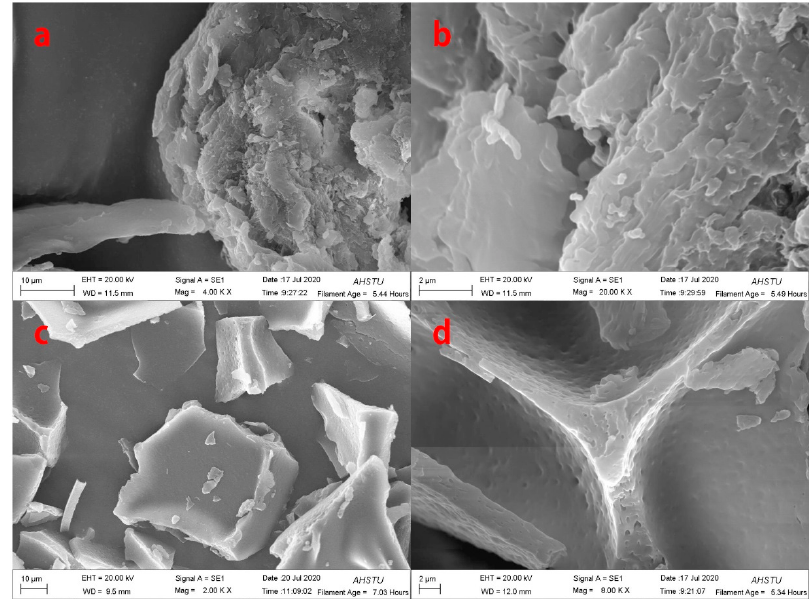
Figure 1. SEM images of: ( a , b ) pig nail powders; ( c , d ) pig nail